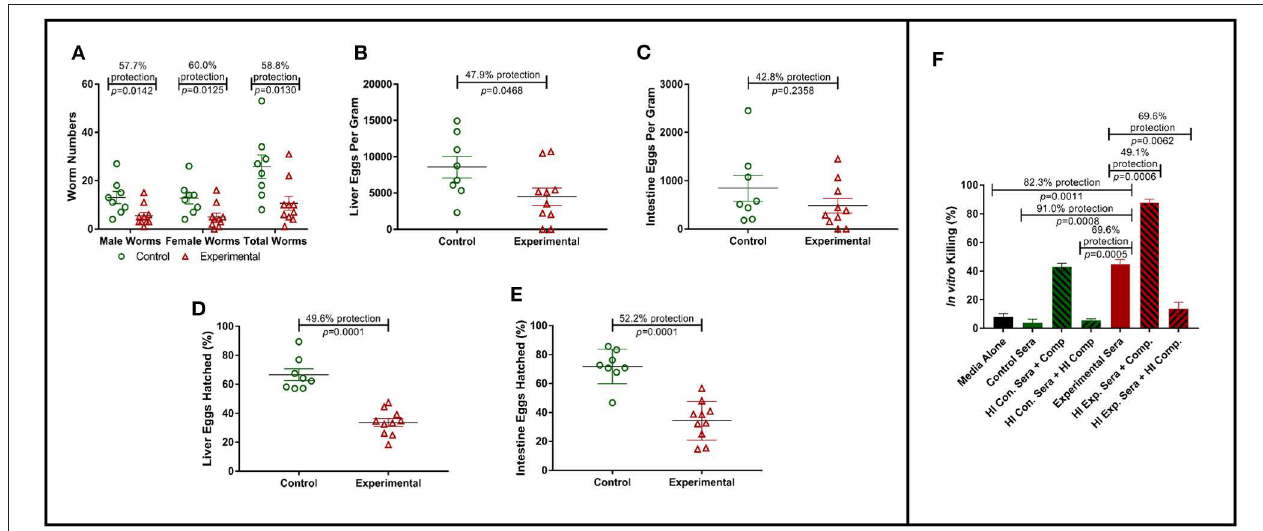
FIGURE 1 | Role of antibodies in Sm-p80-based vaccine-mediated protection. (A) Recovered adult male and female worms following passive transfer of purified IgG from baboons immunized with Sm-p80-based vaccine. (B) Liver egg burden and (C) intestine egg burden at necropsy. Hatching rates of eggs recovered from livers (D) and Intestines (E) of mice at necropsy. (F) In vitro killing of S. mansoni schistosomula in the presence of pooled sera from Sm-p80-vaccinated baboons with addition or absence of exogenous complement. All mice were sacrificed at 6 weeks post S. mansoni cercariae challenge. Plotted data represents individual data points with error bars showing means and standard error of the